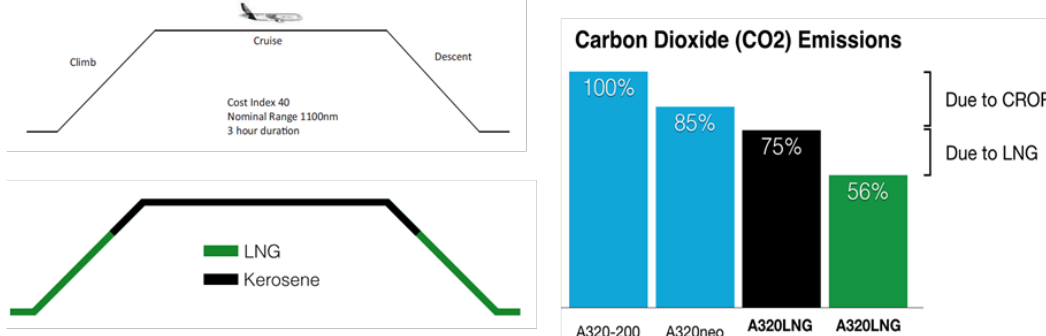
Figure 28. Mission and CO 2 emission reduction from the hybrid A320 class aircraft using LNG and kerosene on a typical mission [46].